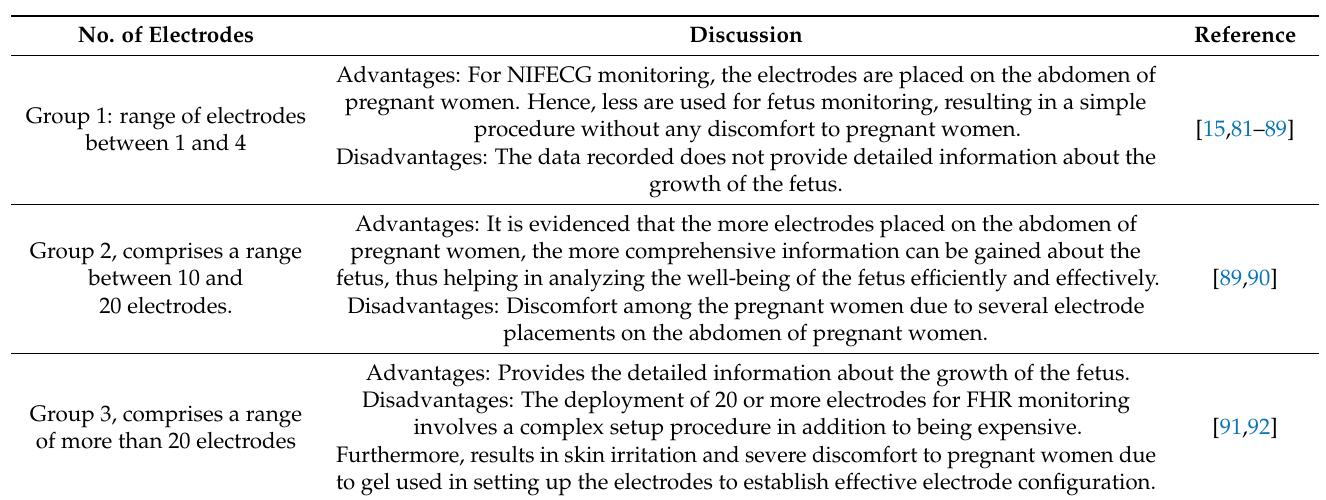
Table 2. Different groups of electrode placement for